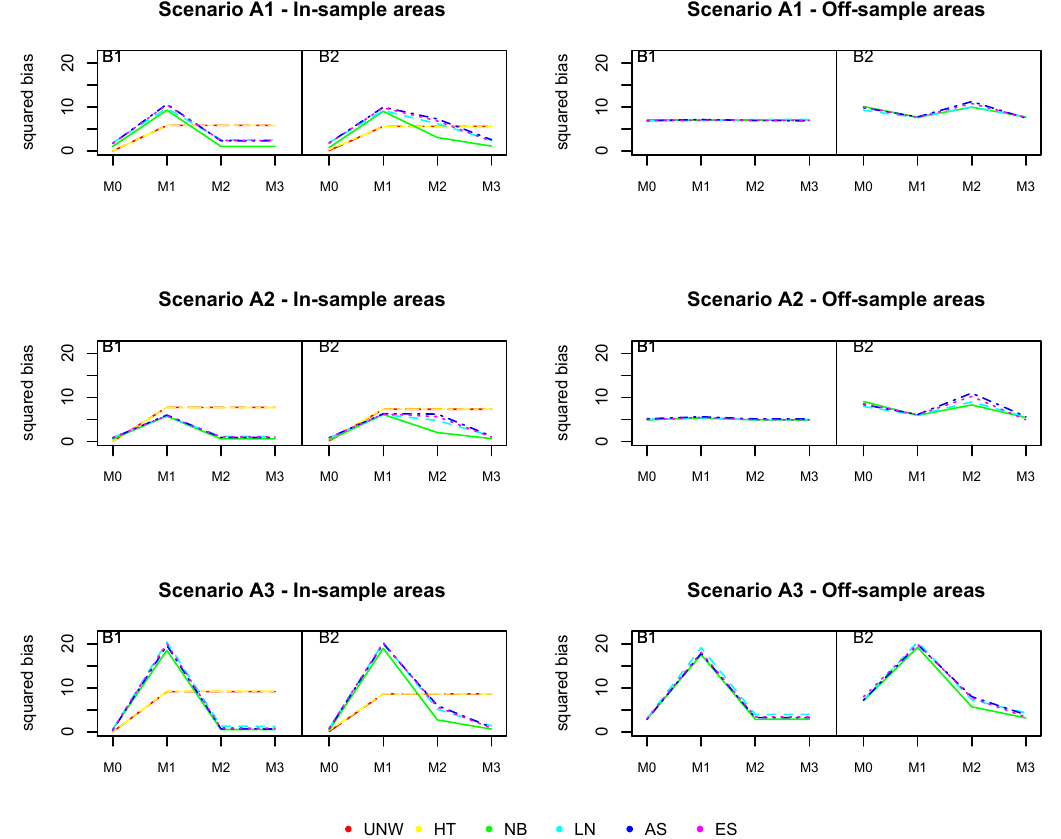
Figure 6. Simulation 2: Squared Bias ( × 10 3 ). UNW = unweighted estimator; HT = Horvitz–Thompson estimator; NB = naive binomial model; LN = logit-normal model; AS = arcsine model; ES = effective sample size model. ( A 1 ) : σ 2 v = 0.15 and σ 2 u = 0.03; ( A 2 ) : σ 2 v = 0.09 and σ 2 u = 0.09; ( A 3 ) : σ 2 v = 0.03